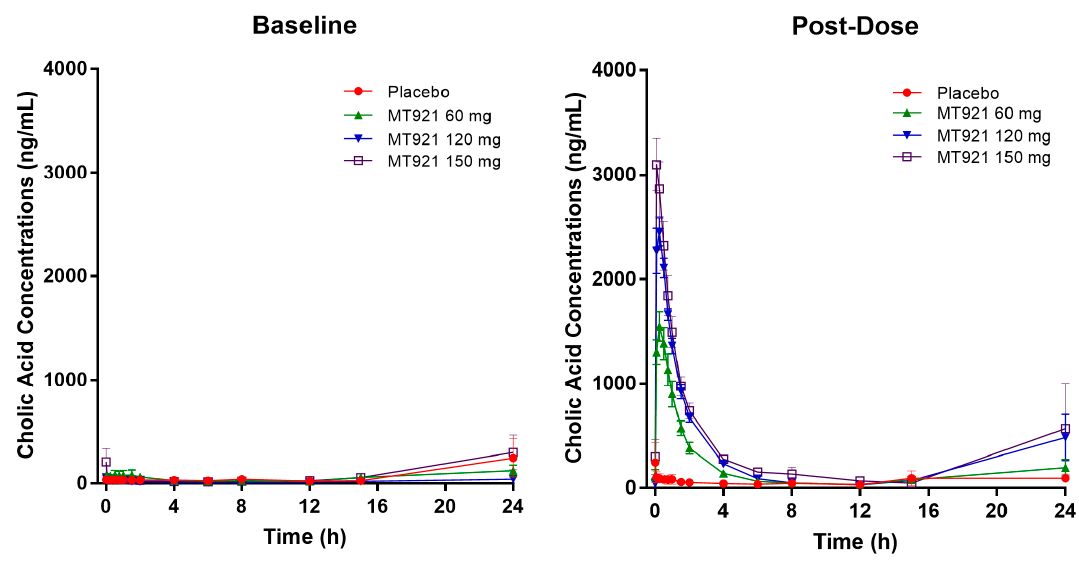
Figure 1. Mean plasma concentration-time profile of cholic acid before and after administration of MT921. Table 2. Pharmacokinetic parameters of cholic acid and deoxycholic acid by dose group.